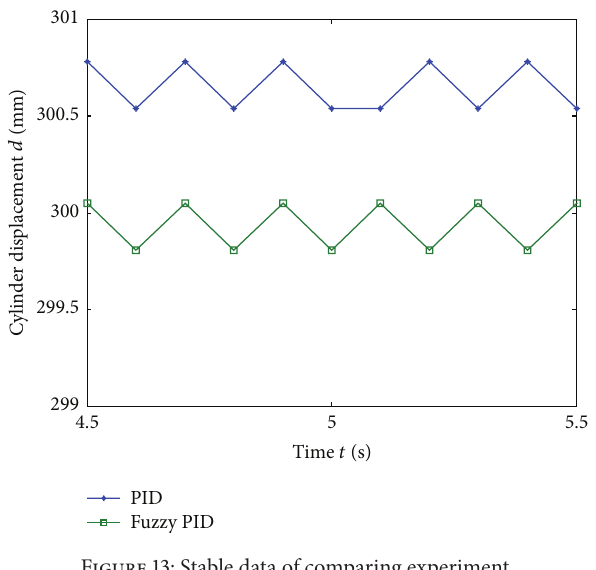
Figure 13: Stable data of comparing experiment.